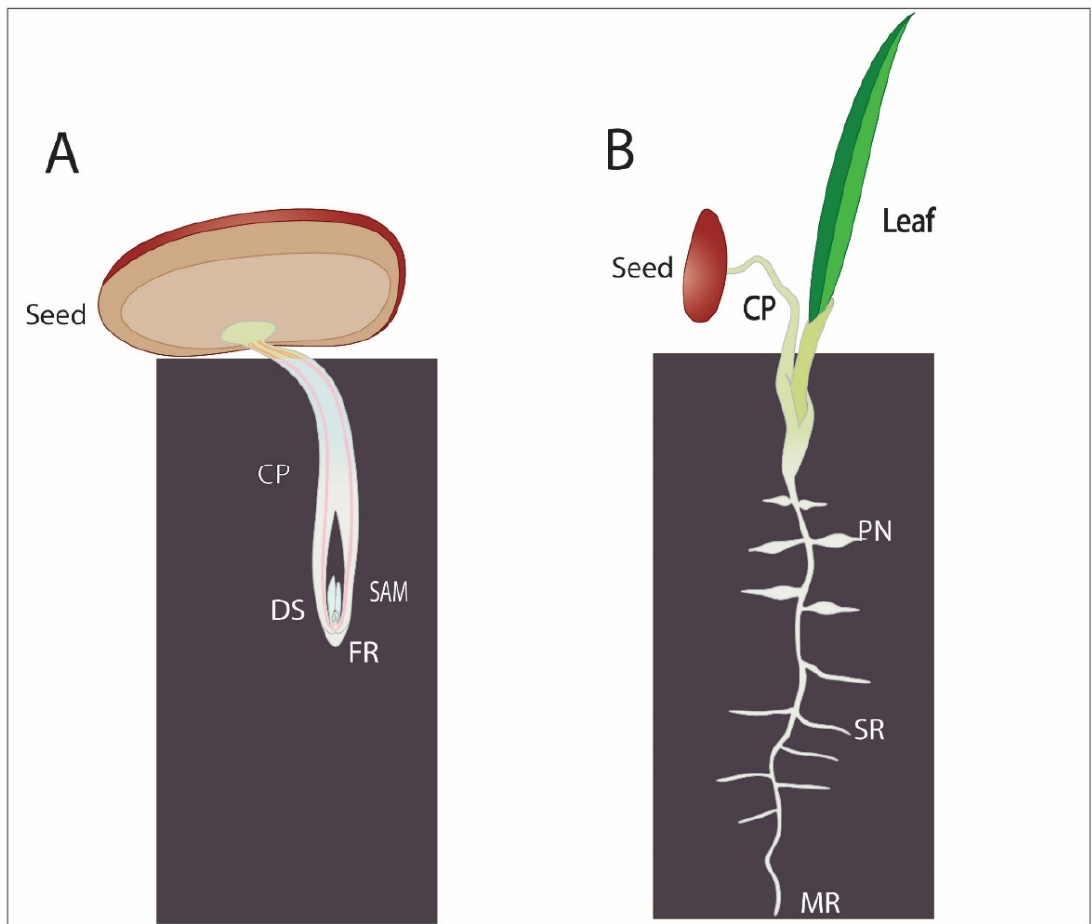
Figure 4. Early developmental processes in date palm. ( A ) Date palm germinating using remote germination. CP: cotyledonary petiole; DS: developing seedling; SAM: shoot apical meristem; FR: future root. ( B ) Date palm seedling: PN: pneumatophores; SR: secondary roots; MR: main roots.